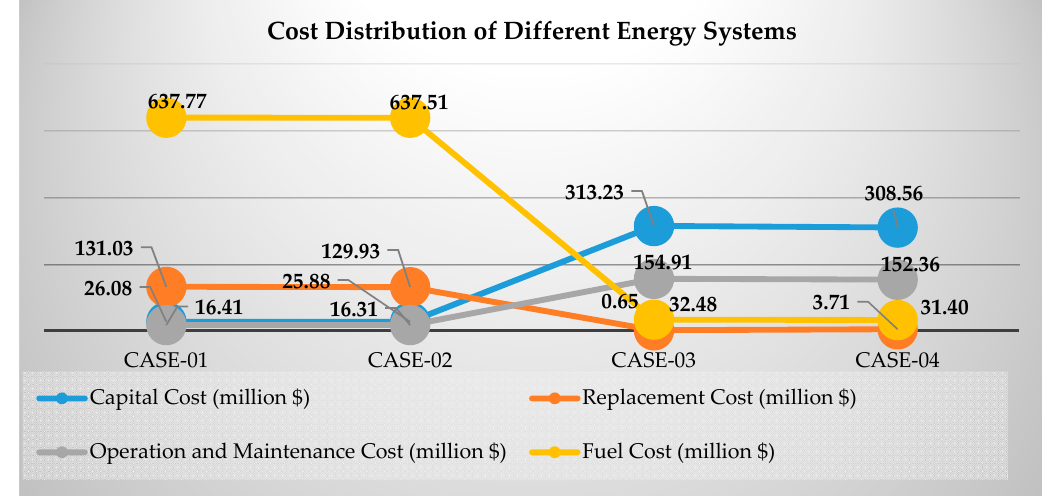
Figure 4. Cost Distribution of Different Energy